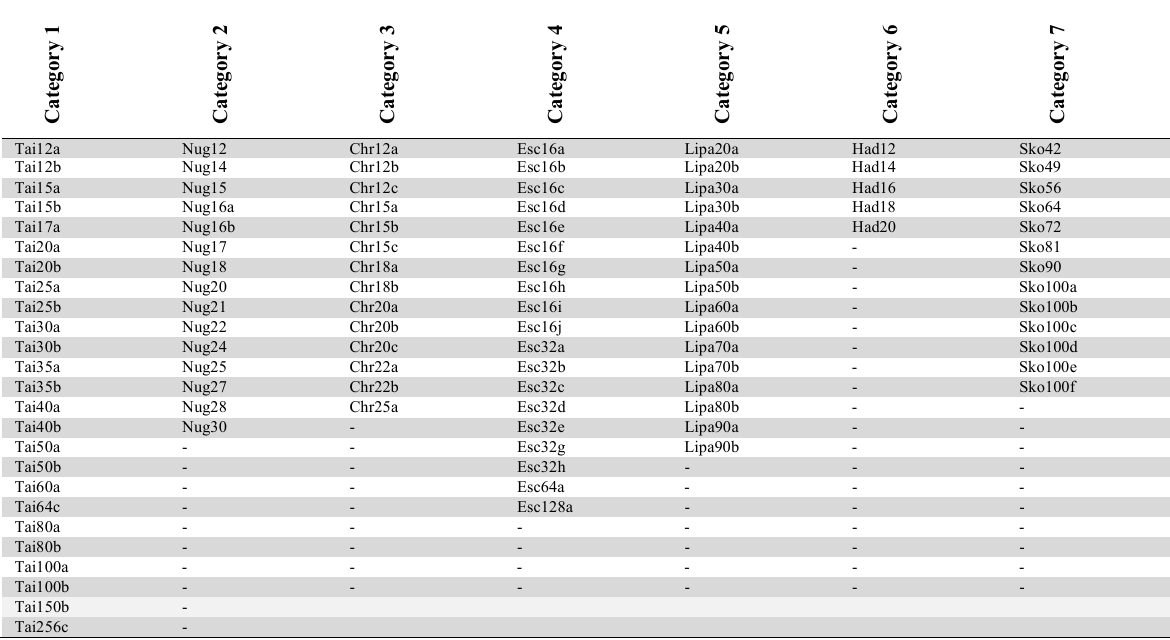
Table 1 Instances of QAP from